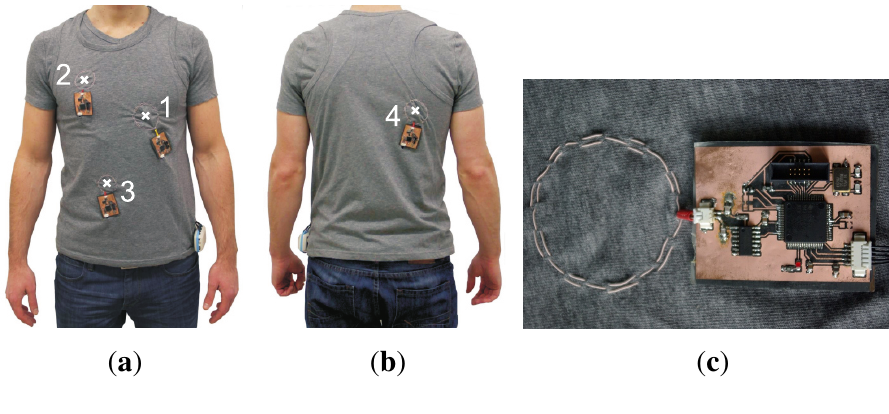
Table 1. Specification of the sensor coils with radius r , number of windings n , base frequency f , coil inductance L and oscillatory capacitance C 0 coil